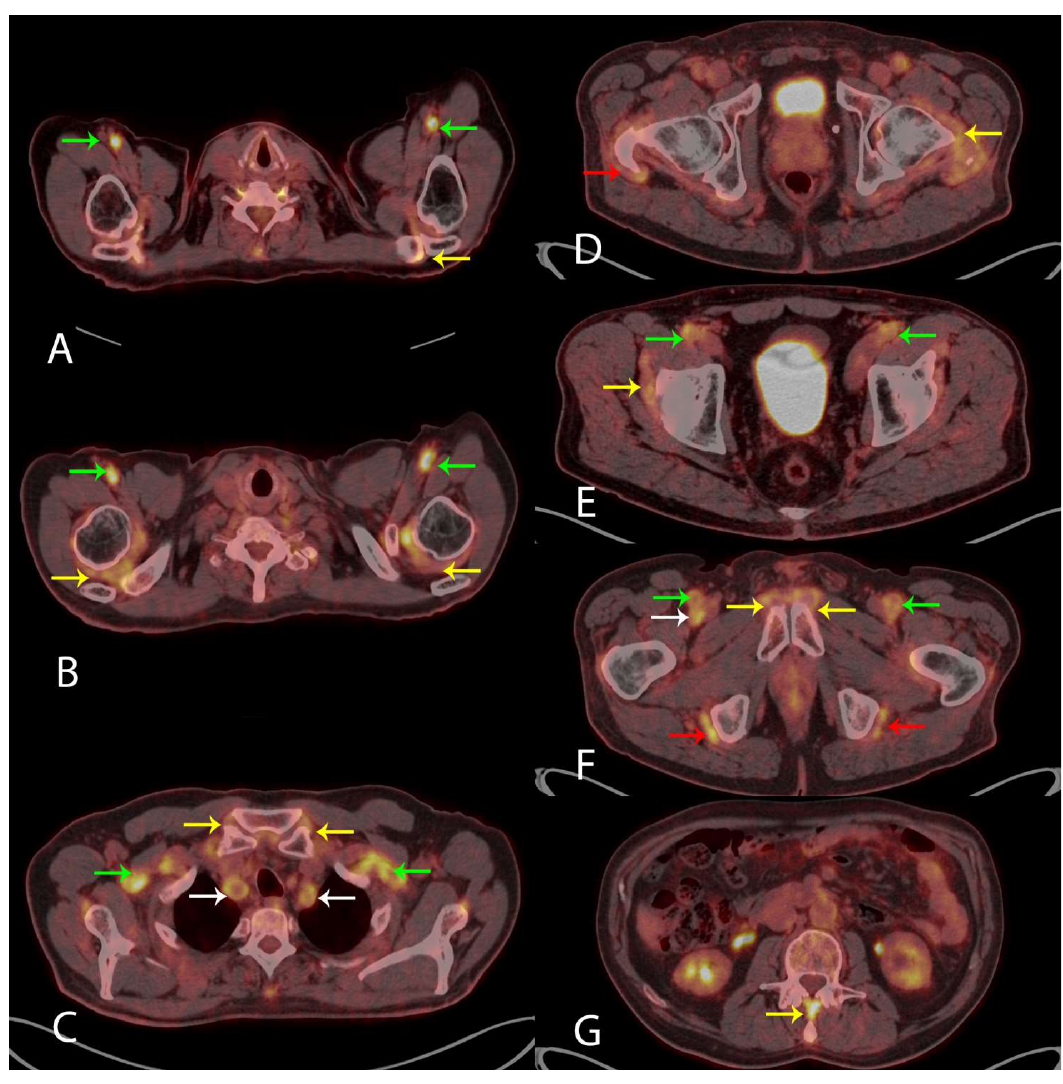
Figure 2. Visually measuring the 18 F-FDG uptake in nine anatomical sites when evaluating the PET/CT scan for the diagnosis of PMR has been suggested [5,6]. These sites include: acromioclavicular joints ( A ) axial fused PET/CT (yellow arrow, left side shown), the high 18 F-FDG uptake in the axillary arteries indicates LVV (green arrows); shoulder joints ( B ) axial fused PET/CT (yellow arrows), LVV in axillary arteries (green arrows); sternoclavicular joints ( C ) axial fused PET/CT (yellow arrows), LVV in subclavian arteries (green arrows) and common carotid arteries (white arrows); hip joints ( D ) axial fused PET/CT (yellow arrow, left side shown) and greater trochanter ( D ) axial fused PET/CT (red arrow, right side shown); the two iliopectinal bursae ( E ) axial fused PET/CT (yellow arrow, right side shown), LVV in common femoral arteries (green arrows); two symphysis pubis enthesis ( F ) axial fused PET/CT (yellow arrows) and two ischial tuberosities ( F ) axial fused PET/CT (red arrows), LVV in superficial femoral arteries (green arrows) and right profound femoral artery (white arrow); and interspinous ligaments ( G ) axial fused PET/CT (yellow arrow), respectively. The specificity of 18 F-FDG PET/CT in the diagnosis of PMR is 95% given that the 18 F-FDG uptake is above the uptake in the liver in ≥ 6 anatomical sites [5]. In our case, the 18 F-FDG uptake met this criterion in all nine anatomical sites (not quantitatively shown). No malignancy was visualized. Based on the clinical information and the results of the 18 F-FDG PET/CT, the patient was treated with 60 mg of Prednisolone resulting in the normalization of blood tests and rapid remission of symptoms. Our case shows that 18 F-FDG PET/CT is a strong supportive imaging tool in the diagnosis of PMR and LVV. 18 F-FDG PET/CT can be used where malignancy is a differential diagnosis, as proposed in the newest European League Against Rheumatism (EULAR) recommendations